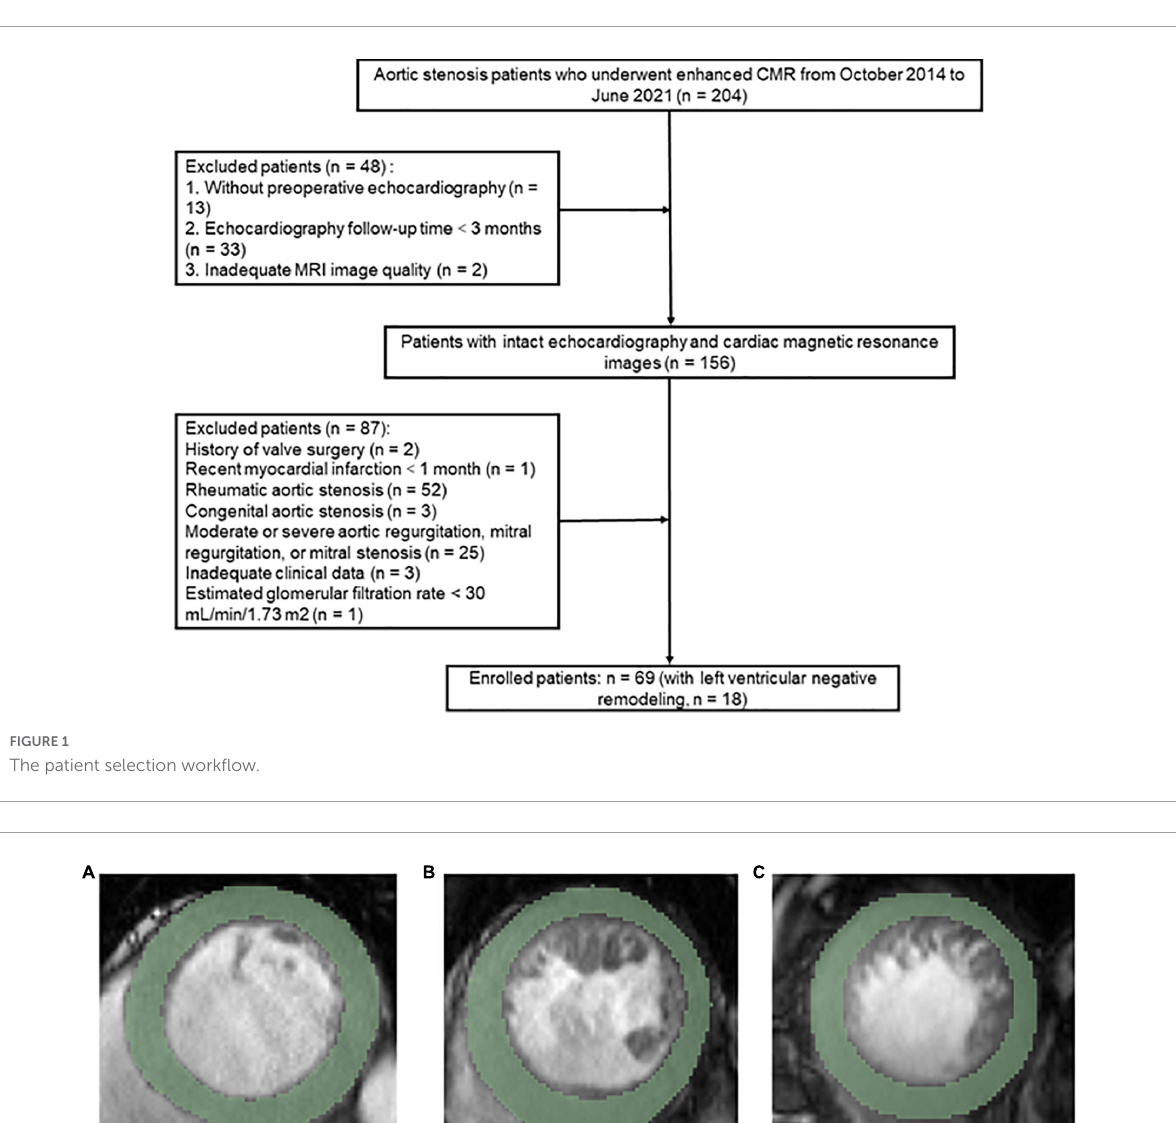
FIGURE2 Representative ROIs segmentation in basal level (A) , middle level (B) , and apical level (C)